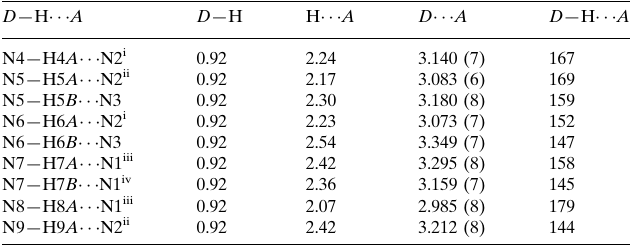
Hydrogen-bond geometry (A˚ , (cid:3)